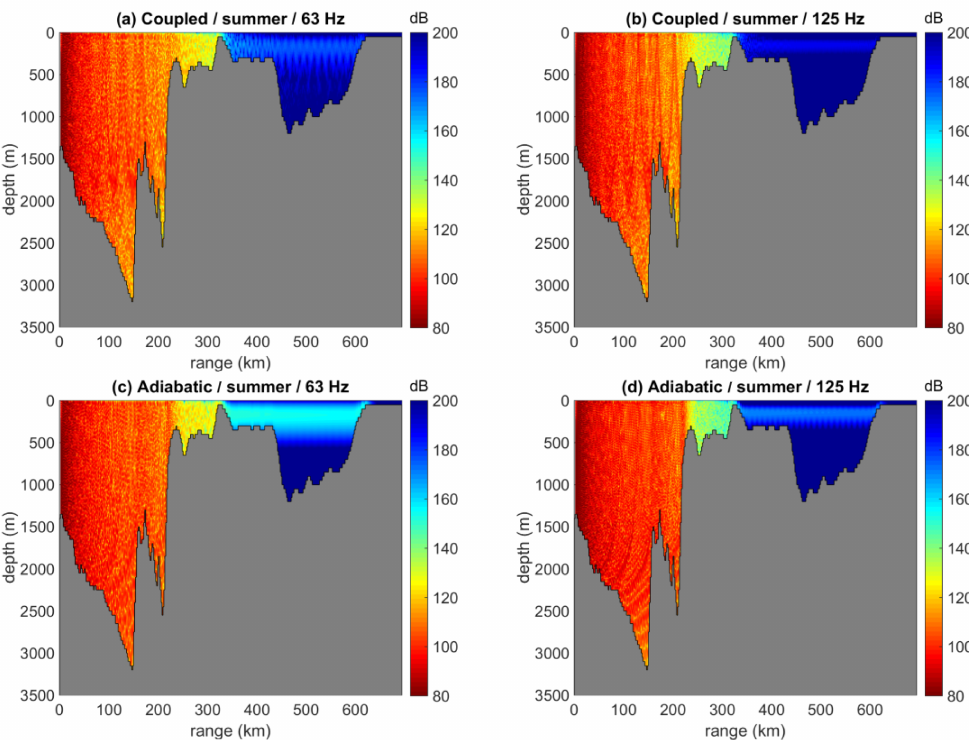
Figure 9. Transmission loss (dB) along transect CD for the summer SVP for a source depth of 5 m. ( a ) Coupled-mode results at 63 Hz; ( b ) Coupled-mode results at 125 Hz; ( c ) Adiabatic results at 63 Hz; ( d ) Adiabatic results at 125 Hz.